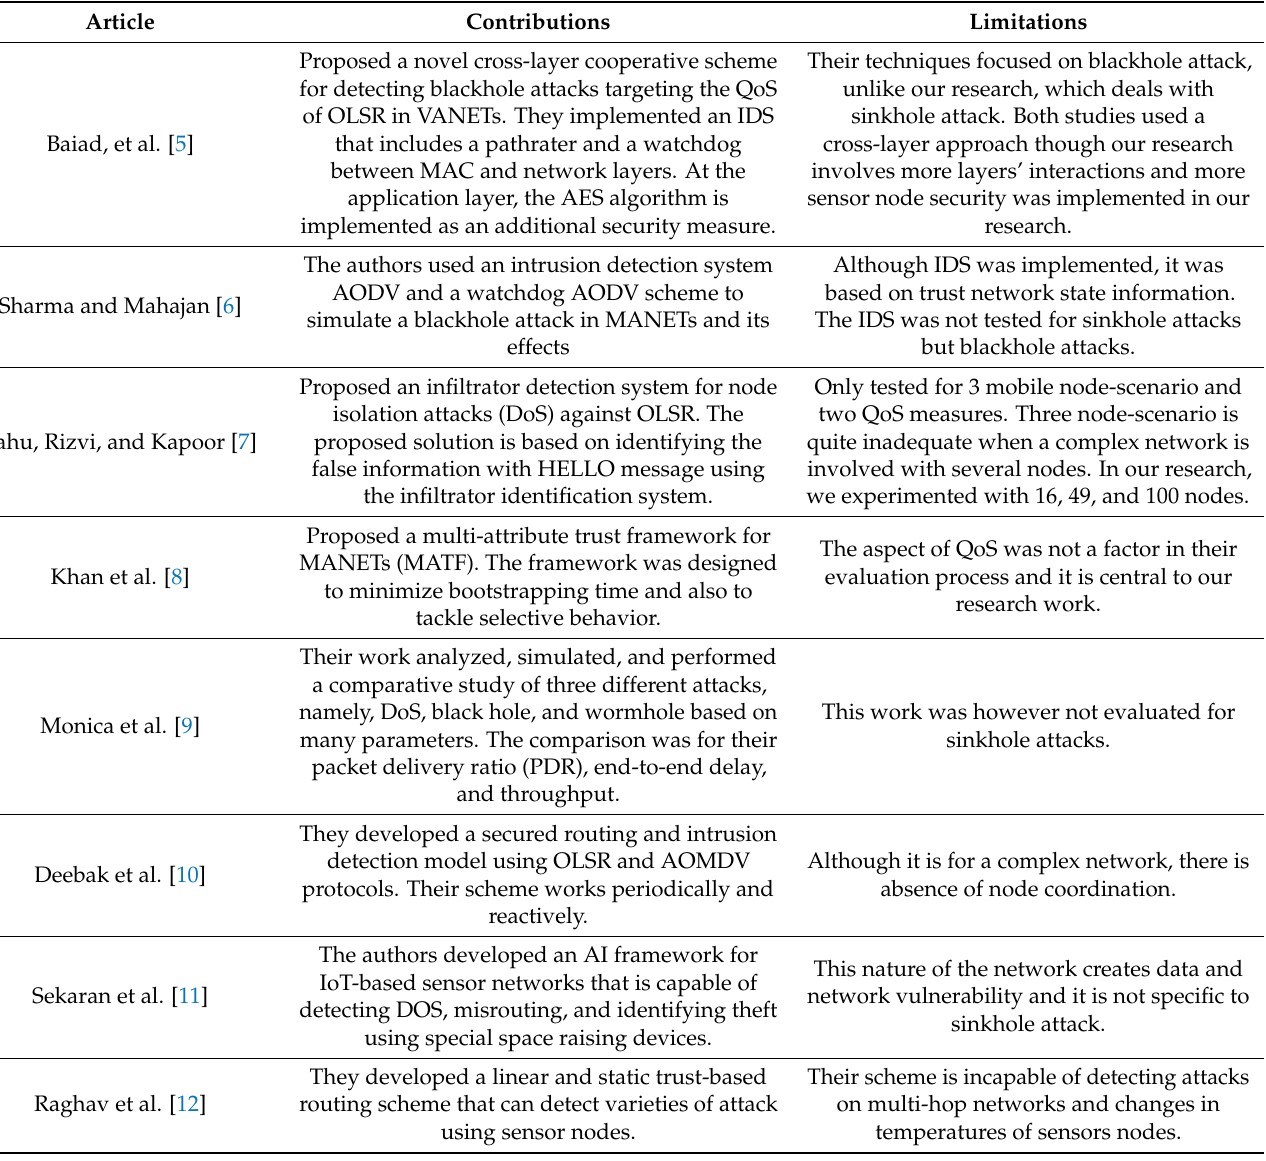
Table 1. Related works-contributions and